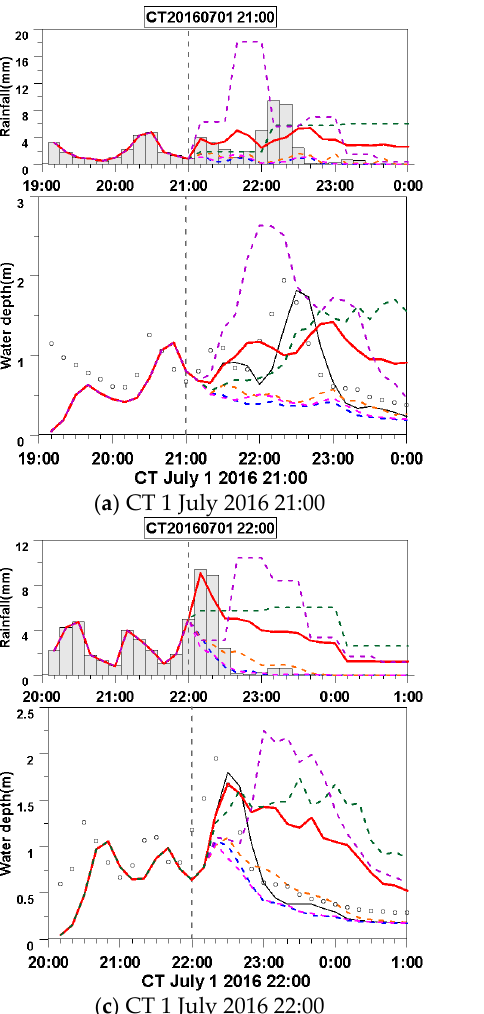
Figure 11 . Comparisons between observed and simulated rainfall data using water depth in pipe at three locations in Gangnam for Case 2 (July 1, 2016) over time.